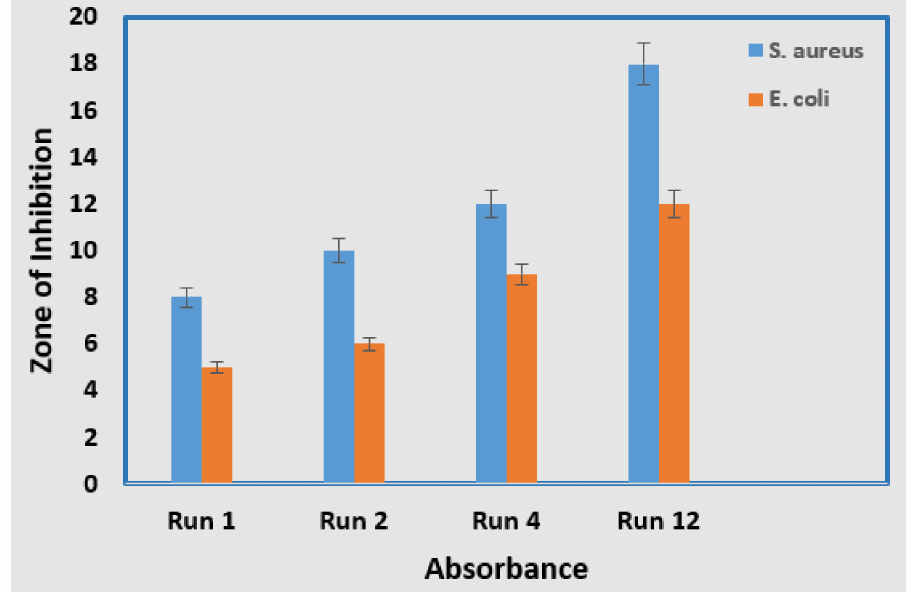
Figure 12. Graph shows the maximum zone of inhibition against the E. coli bacterial